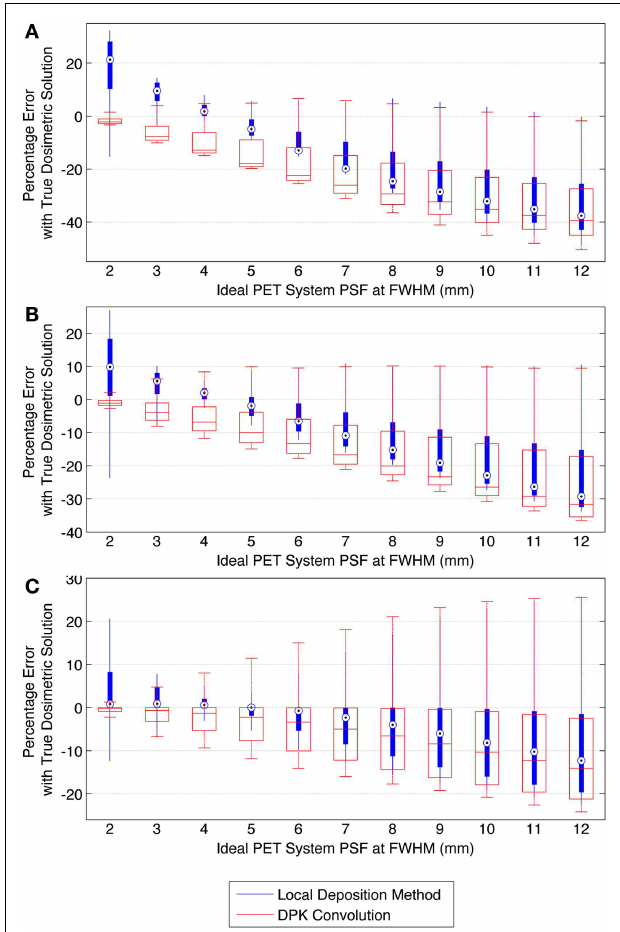
FIGURE 10 | Comparison of error using LDM or DPK convolution with theTDS based on mathematical phantoms with no noise and ideal PET scanner PSF for a 2mm isotropic voxel size . For each simulated PSF, percentage errors between either the LDM or DPK DVH and theTDS DVH for every dose ( D ) in the DVH were computed. Boxplots indicate mean error, 25th and 75th percentile of the distribution as well as upper and lower extremes across all doses, D . (A) 10mm hot-sphere, (B) 17mm hot-sphere, and (C) 37mm